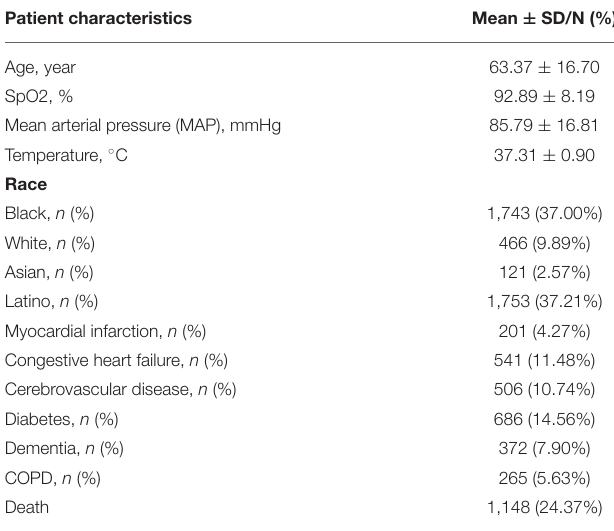
TABLE 1 | The clinical characteristics of